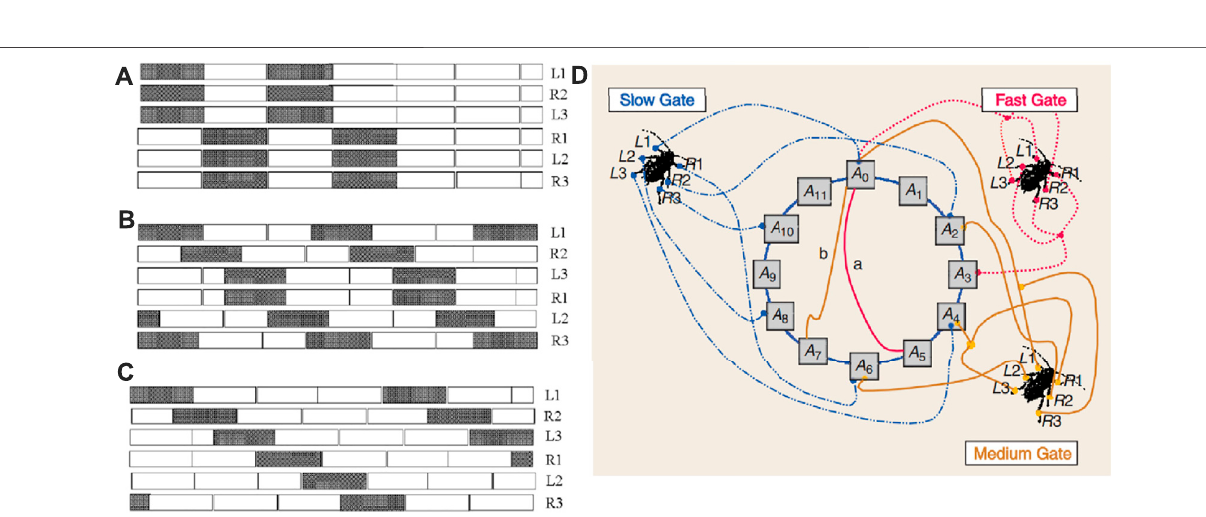
FIGURE 6 | Turing pattern associated to the fast-gait. The pattern is characterized by two equilibrium values (depicted in black or white), which de fi ne the two groups of legs that have to move simultaneously: the tripod R1, L2, R3 and the tripod L1, R2, L3.